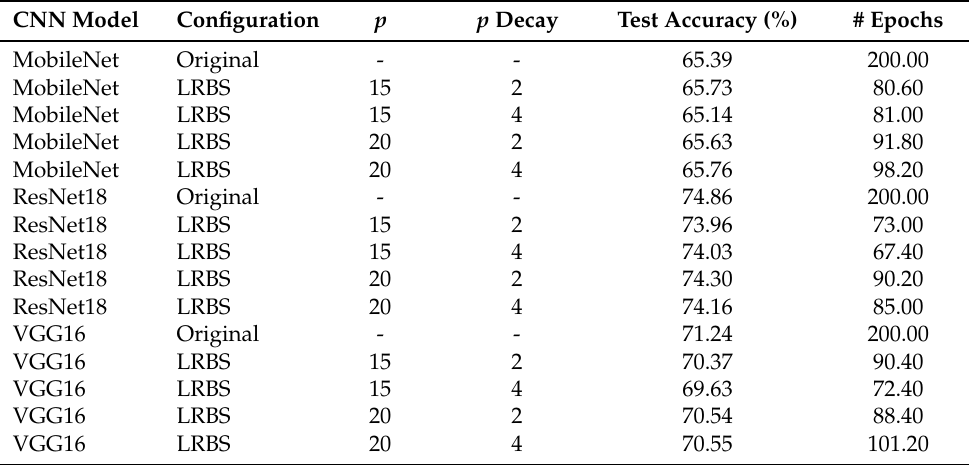
Figure 1. Performance of the various training for MobileNet on CIFAR-100. The blue bars represent the accuracy on the test set (left axis), the yellow squares report the number of epochs needed (right axis) and the red dotted line is the accuracy provided by the reference training. Table 1. Results obtained on the three CNN models on the CIFAR-100